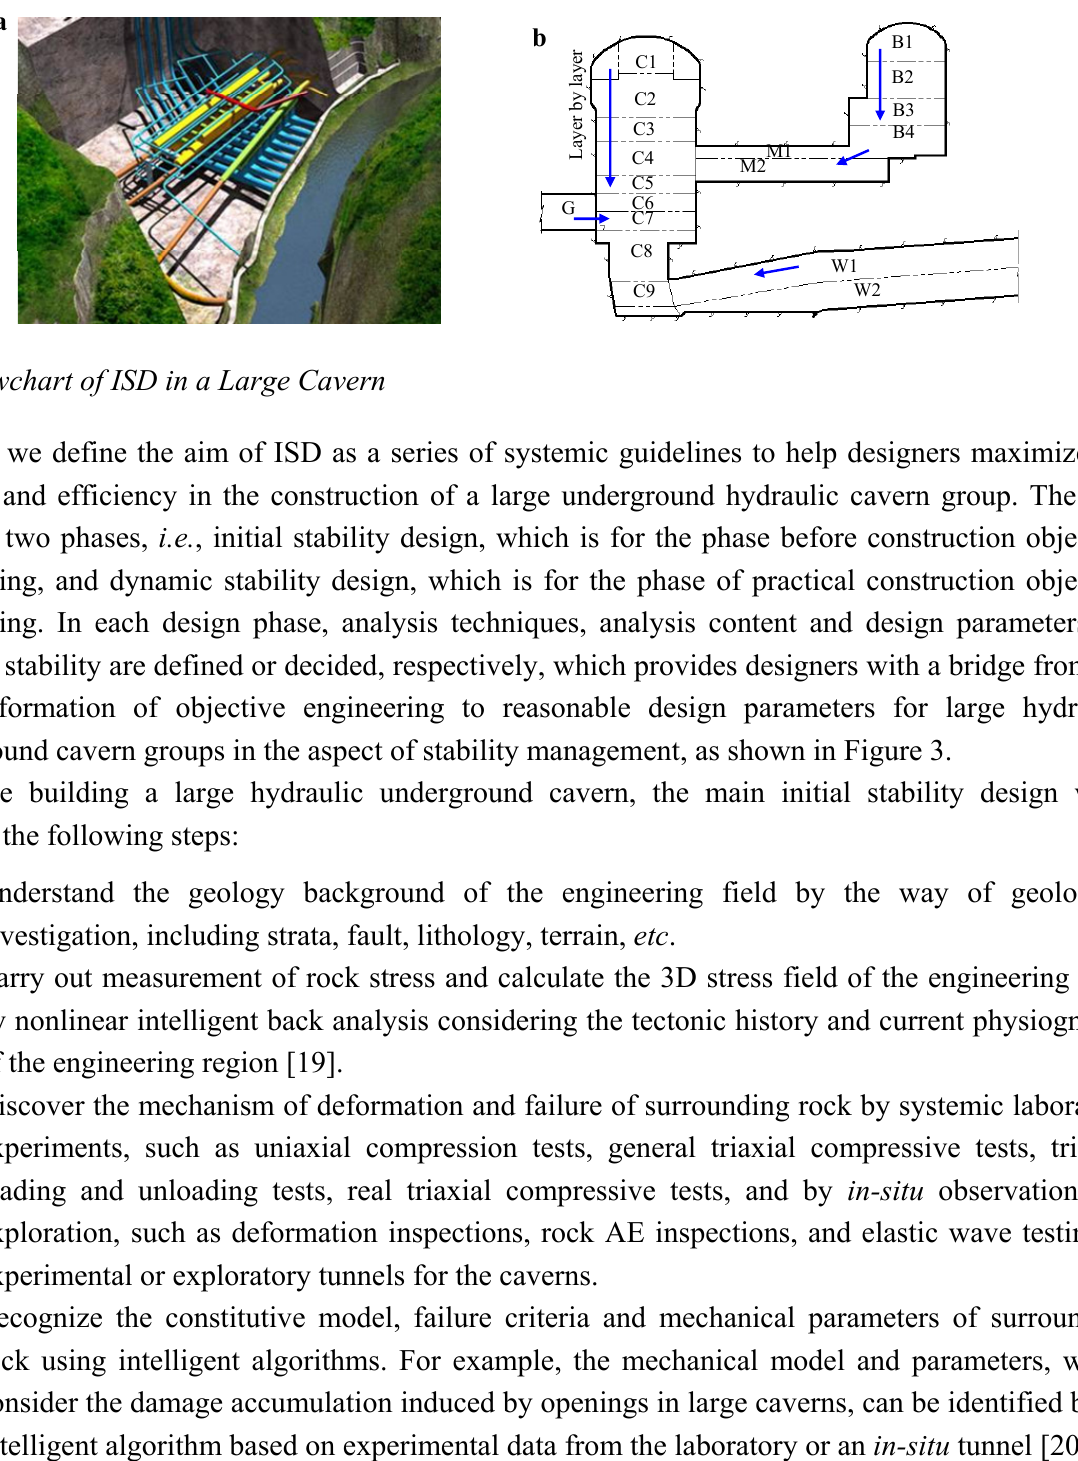
Figure 2. 3D excavation sequence of large underground caverns. ( a ) hydropower generation multi caverns; ( b ) 3D spatial opening